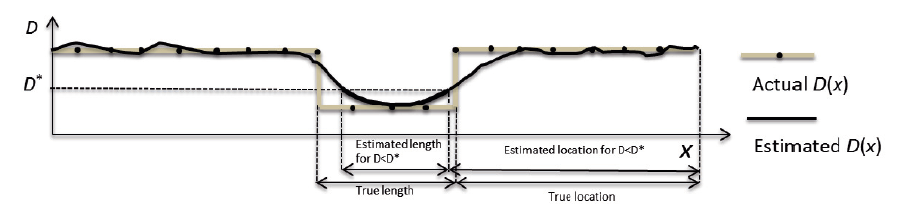
Figure 20. Estimated diameter and actual diameter along the length of the pipeline at point X